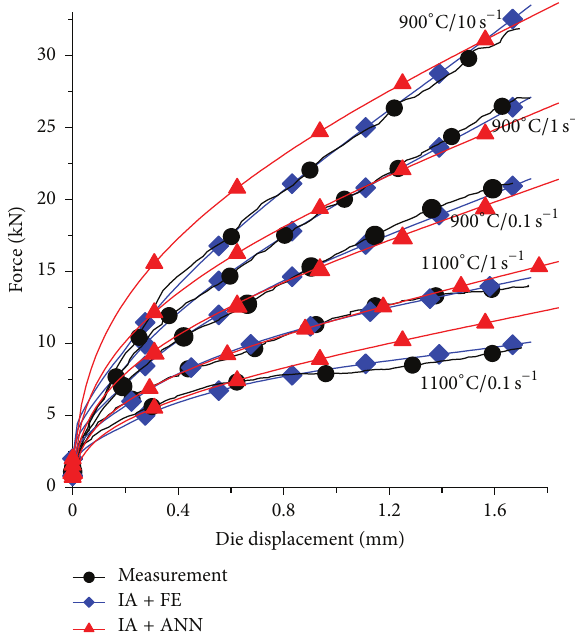
Figure 23: Comparison of forces measured in the ring compression tests for the St3S steel and calculated by the FE code with (3) with the coefficients obtained from the inverse analysis with the